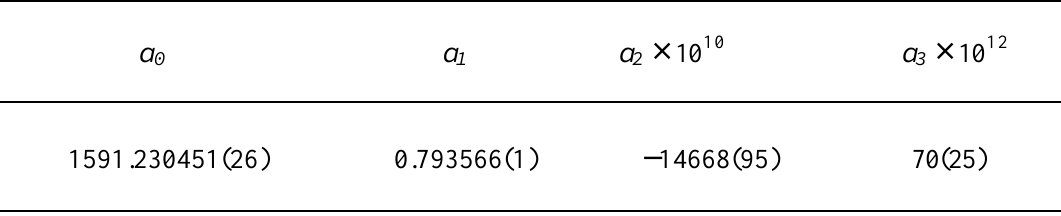
Table 3. Taylor-Series Expansion Coefficients (in cm - 1 )